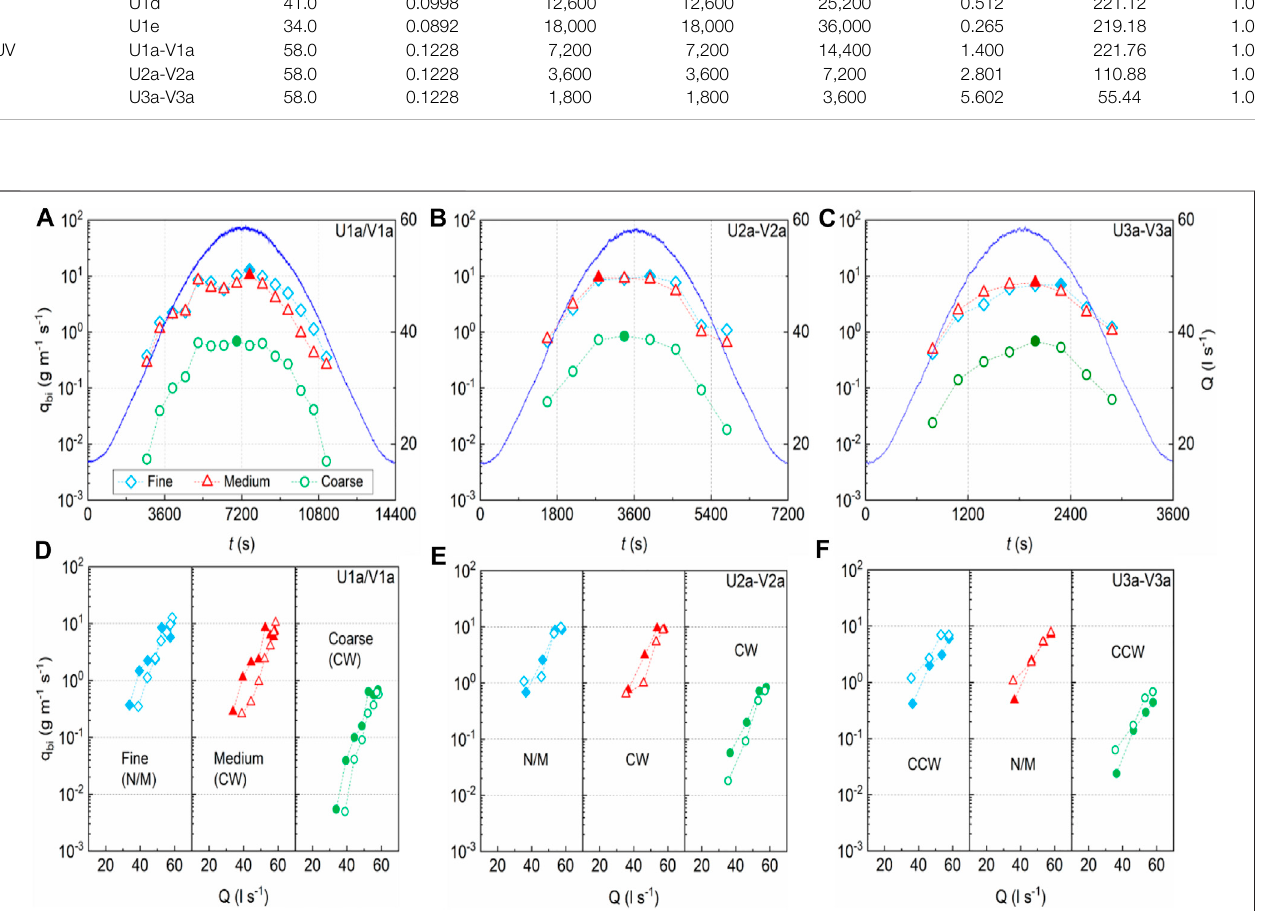
Frontiers in Environmental Science |